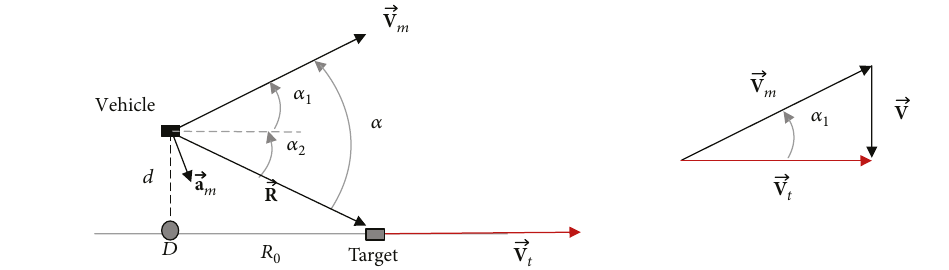
Figure 3: Linear model for straight-line path following.